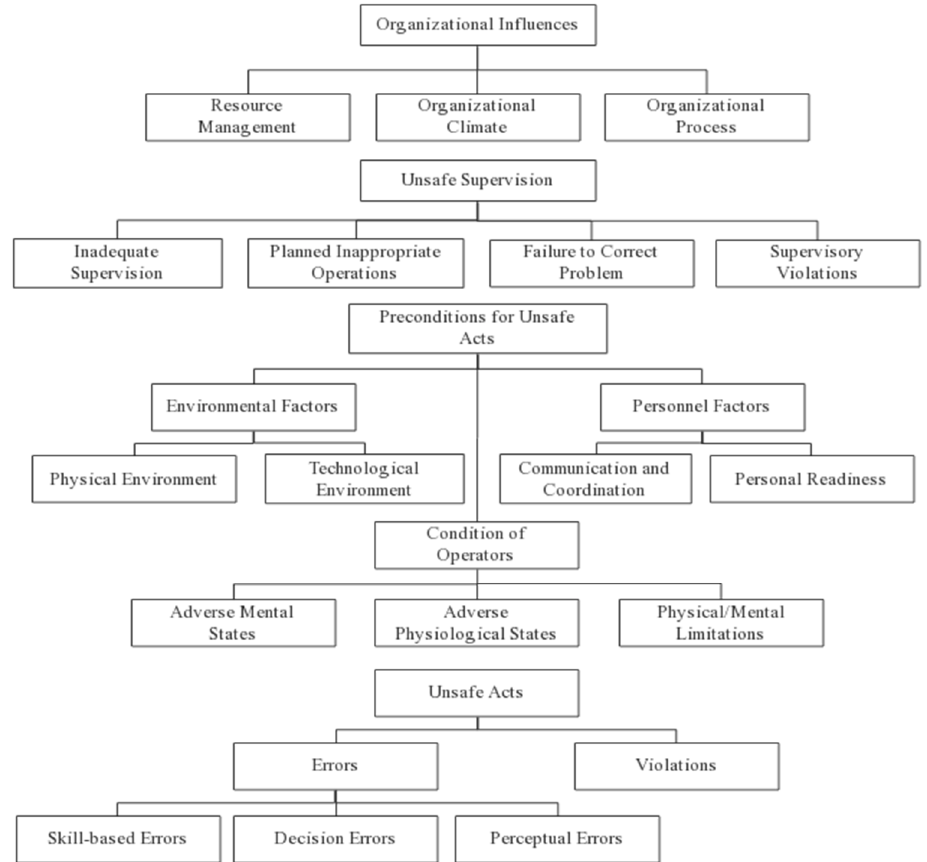
Figure 1. HFACS frame diagram of hazardous chemical storage accidents.